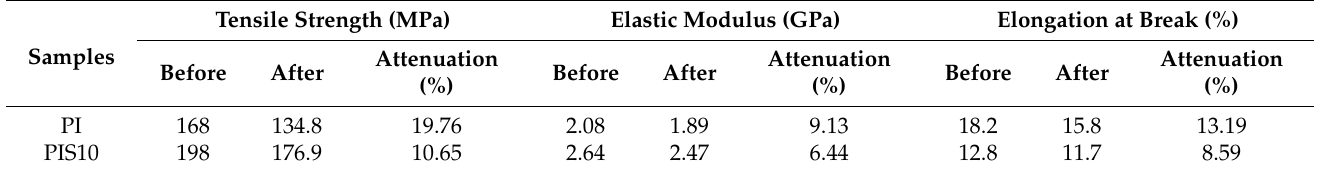
Table 2. The mechanical properties of the pure PI film and the PIS10 before and after irradiation. Tensile Strength (MPa) Elastic Modulus (GPa) Elongation at Break (%) Samples Before After